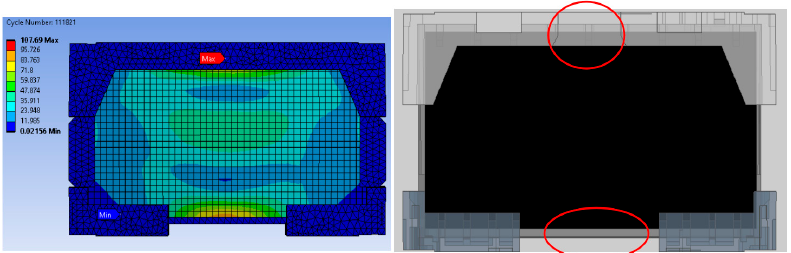
Figure 12. Analysis result of model D.